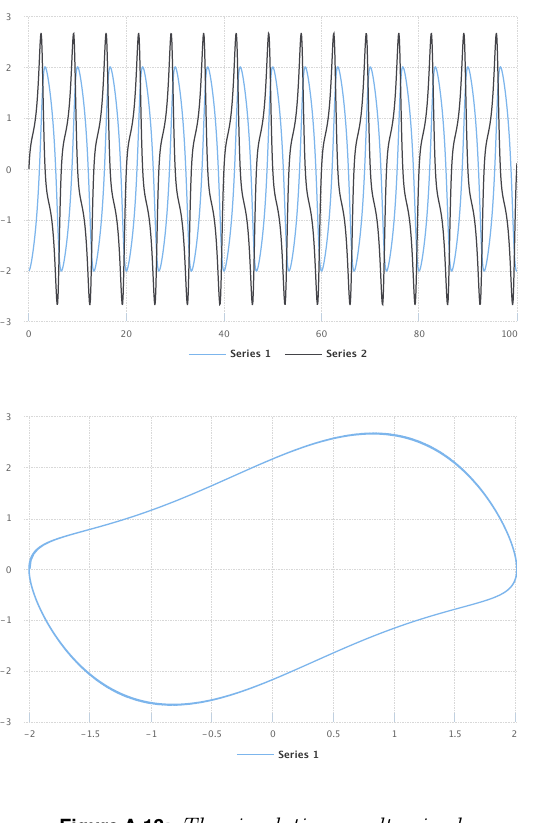
Figure A.13: The simulation result gained from the simulation description given in Listing A.8. Simulation with SED-ML web tools [2].